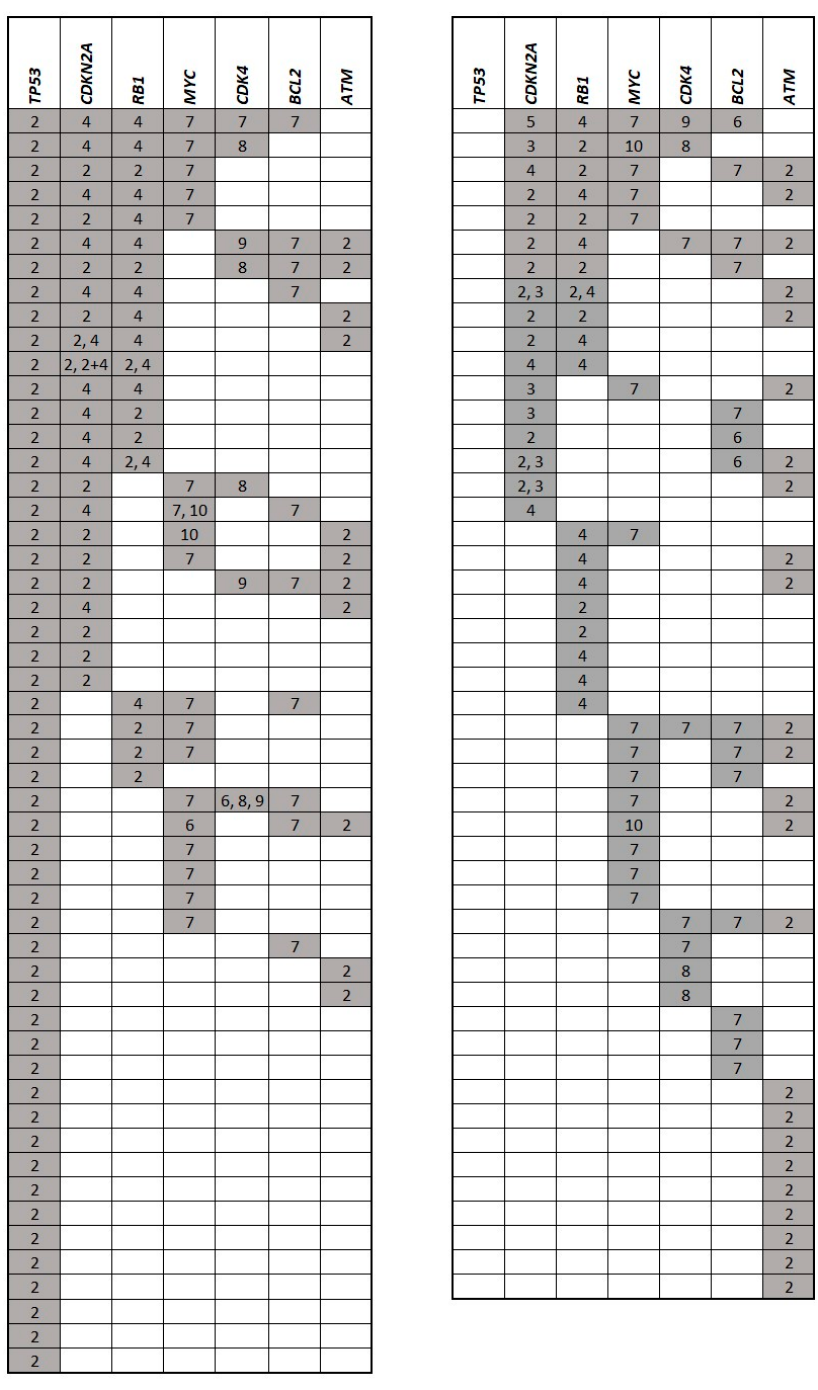
Figure 3. Distribution of the analyzed aberrations of 101 patients with at least one detected aberration including TP53 mutation except for the translocation t(11;14). Each row represents one patient, gray squares represent aberrated genes, numbers represent type of aberration: 2 = monoallelic deletion (in case of TP53 and / or mutation), 3 = bialellic deletion, 4 = monosomy, 5 = nullisomy, 6 = amplification, 7 = gain, 8 = trisomy, 9 = tetrasomy, 10 = MYC rearrangement.